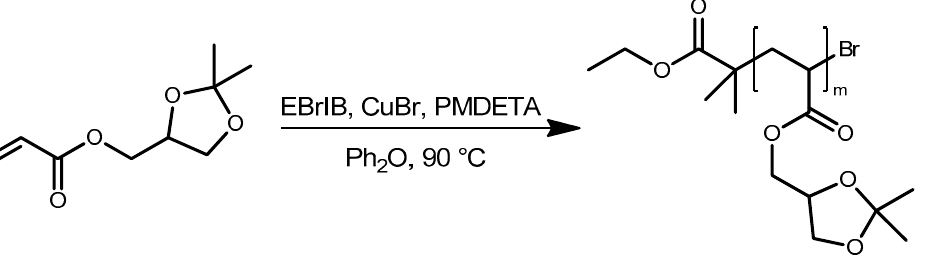
Table 8. Synthesis of the poly(solketal acrylate) macroinitiator. Figure 9. Synthesis of poly (solketal acrylate) (PSKA)macroinitiators using ATRP.